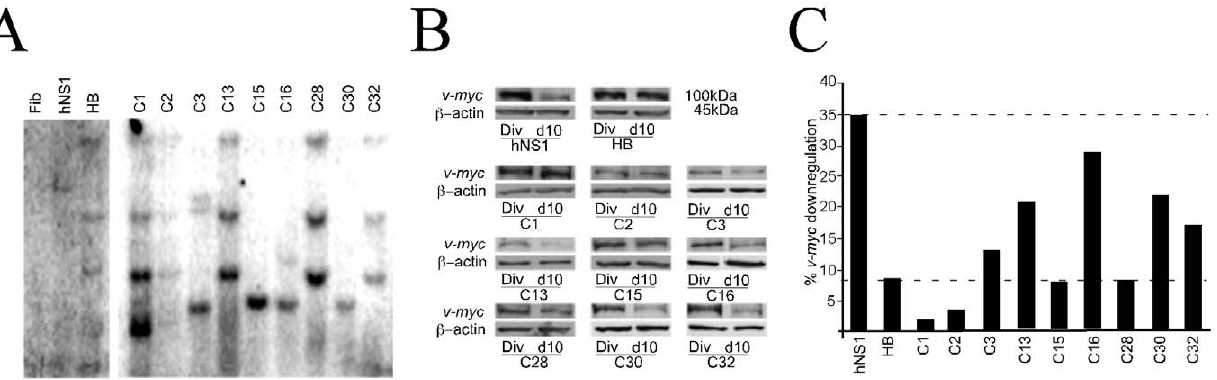
Figure 2. v-myc integrations and downregulation upon differentiation. A) Southern blot showing the number of integrated copies of v- myc vector in each clone and cellular lines used as controls. Human fibroblasts (Fib), negative control; clonal human forebrain neural stem cells (hNS1), known to have only one insertion [35]; polyclonal hVM1-BclX L cell line (HB) expected to show multiple integrations since it is composed of a library of clones. B ) Examples of Western blots showing v- myc protein detection. Samples of total protein were extracted under proliferation (Div) and after 10 days of differentiation (d10) conditions for each clone and control cell lines. Note that the clonal hNS1 cells downregulate vector expression whereas the level of v-myc protein is still high in the HB cells after 10d of differentiation. C) v-myc protein signal in the blots was quantified using Image J software. The degree of downregulation (10 d/Div) is represented. The extent of down-regulation of v- myc protein obtained for hVM1-Bcl-X L cells (HB) was 8.3% and was taken as the minimum acceptable down-regulation that a clone should have. Thus, clones with a downregulation over 8.3% were considered. The value obtained for the downregulation of the clonal forebrain hNS1 cell line, 34.7%, would be the ideal or maximal